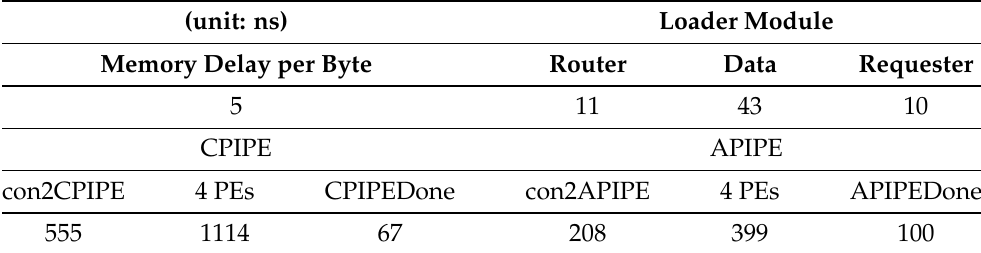
Table 2. Estimated execution time for each submodule in DLA.